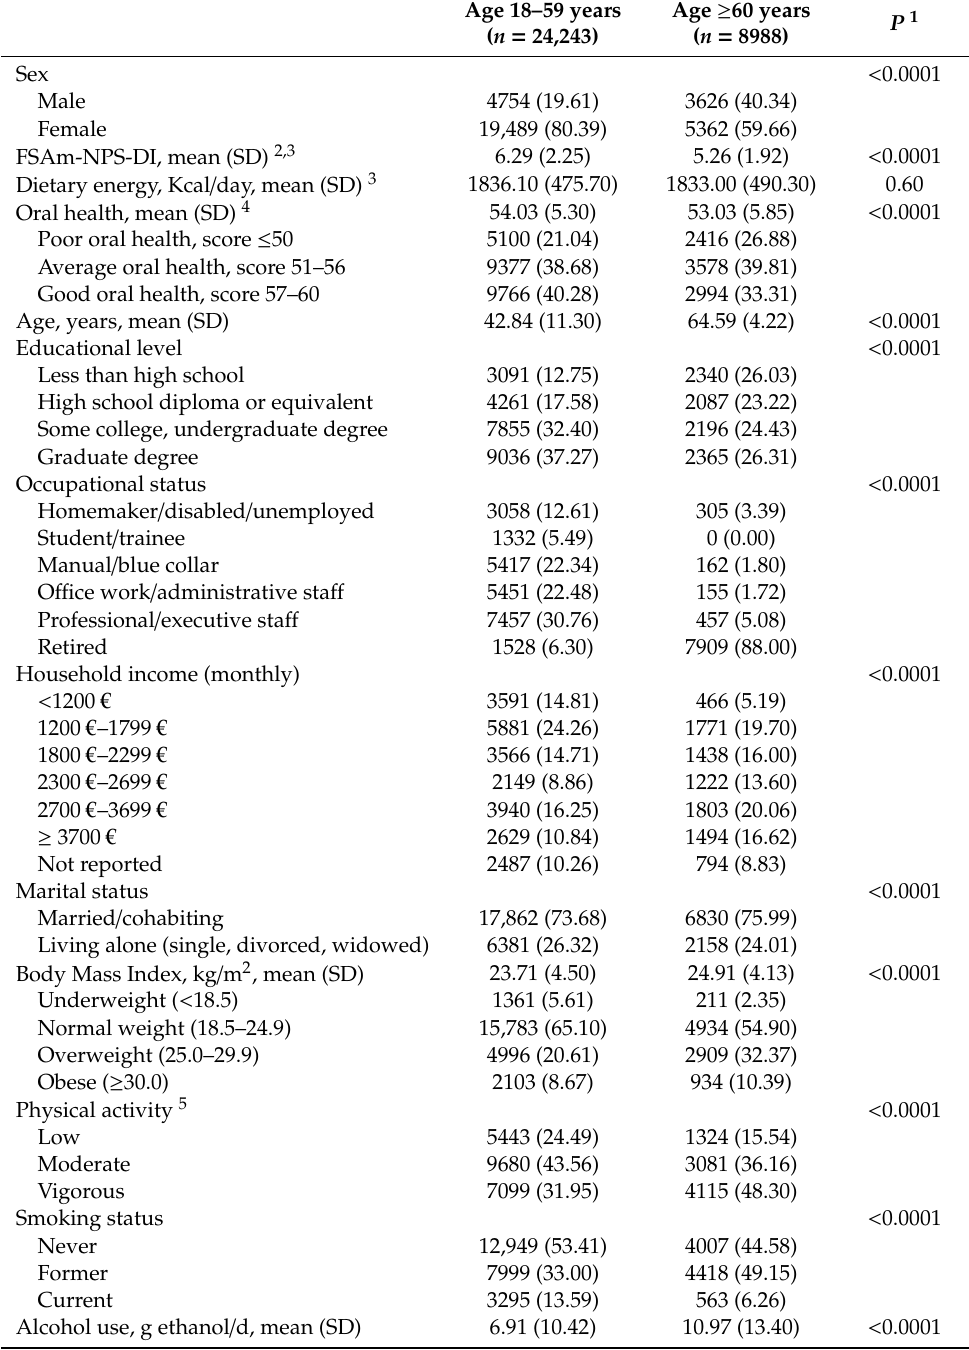
Table 1. Descriptive characteristics of NutriNet-Sant é participants by age